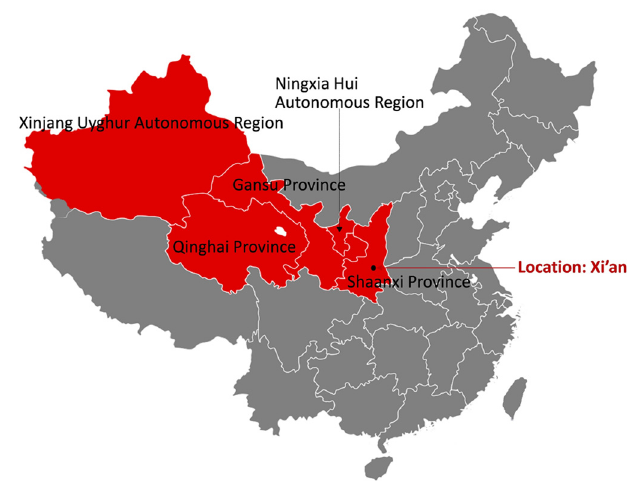
Figure 1. Regions in north-western China under administrative classification.